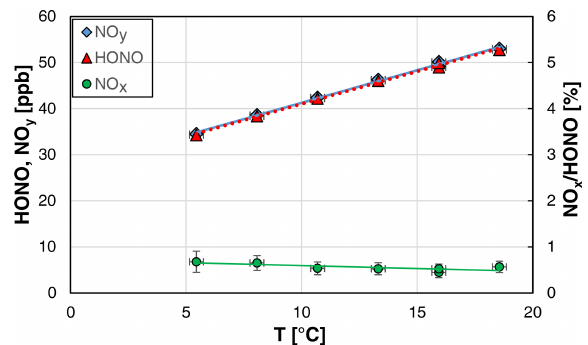
Figure 7. Temperature dependence of NO y , HONO, and the NO x / HONO ratio of the HONO source (NO − ∅ , dry = 1570cm 3 min − 1 , 20rpm, pH = 2.46). The y error bars φ g represent the precision errors (2 σ ), which are only visible for the NO x / HONO ratio but smaller than the size of the symbols for HONO and NO y . Accuracy errors of the temperature of ± 0.3 ◦ C are also shown.